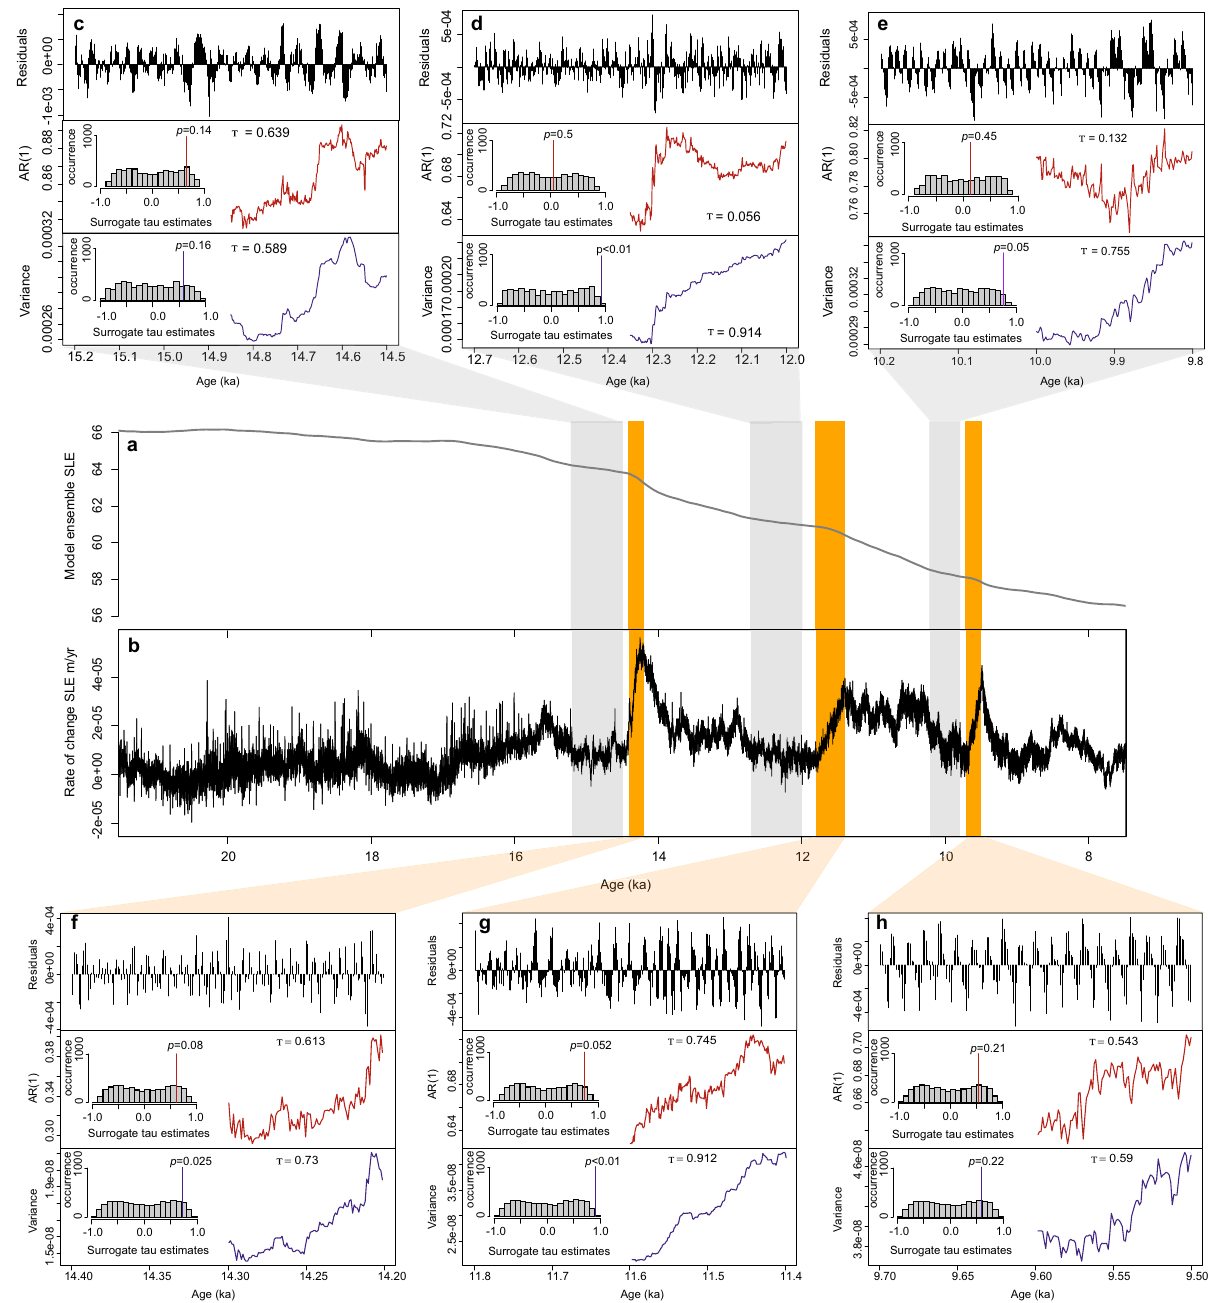
Fig. 5 Tipping point analysis for deglacial model simulations. a Model ensemble of sea-level equivalent (SLE) mass loss (m/yr) and b SLE rate of change (m/yr). Orange and gray columns depict data selected for analysis of destabilization and re-stabilization, respectively. Tipping point analysis for the data prior to destabilization ( c – e ) and data prior to re-stabilization ( f – h ) of the AID-like event, from top: data residuals, autocorrelation (red) and variance (purple), over a 50% sliding window. Histogram showing Kendall tau correlation coef fi cients for surrogate time series, and corresponding p values for autocorrelation (red lines) and variance (purple